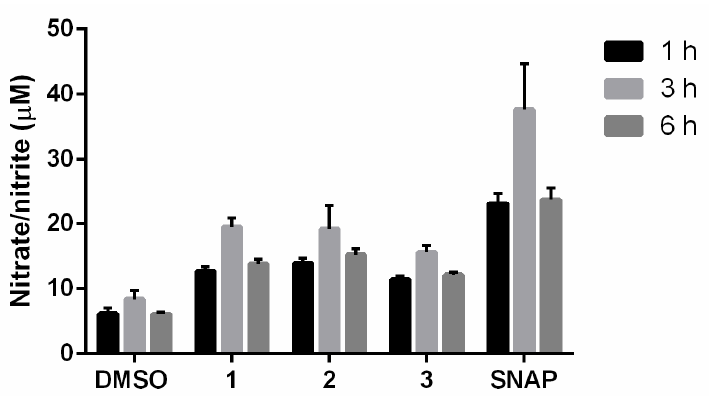
Figure 3. Levels of ·NO produced by furoxans derivatives in physiological solution at pH 7.4 and 37 °C. The results are the means ± standard deviation of three independent experiments. SNAP is the ·NO-releasing positive control compound.